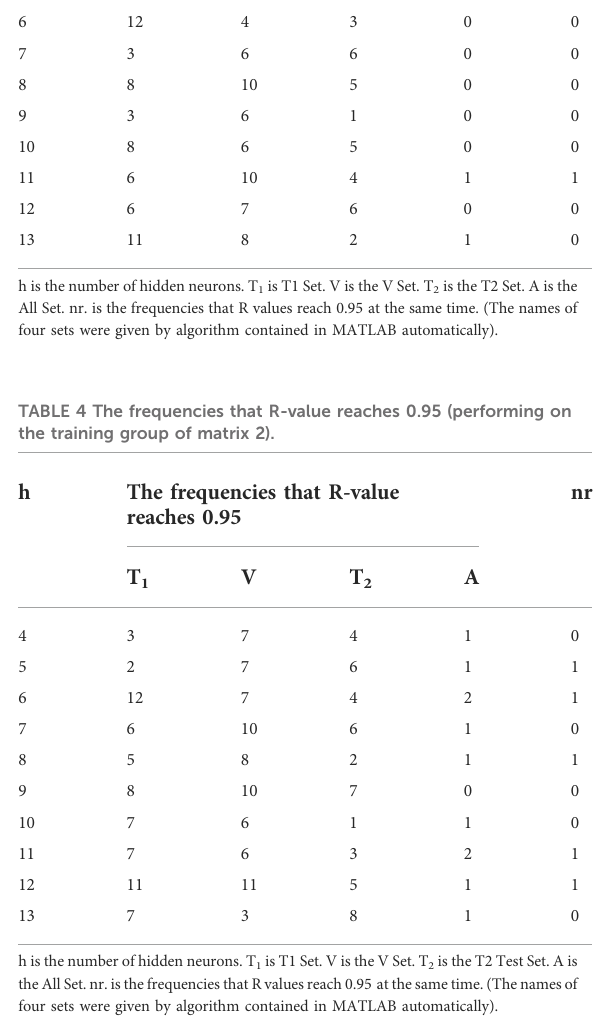
TABLE3ThefrequenciesthatR-valuereaches0.95(performingonthe training group of matrix 1). h The frequencies that R-value reaches 0.95